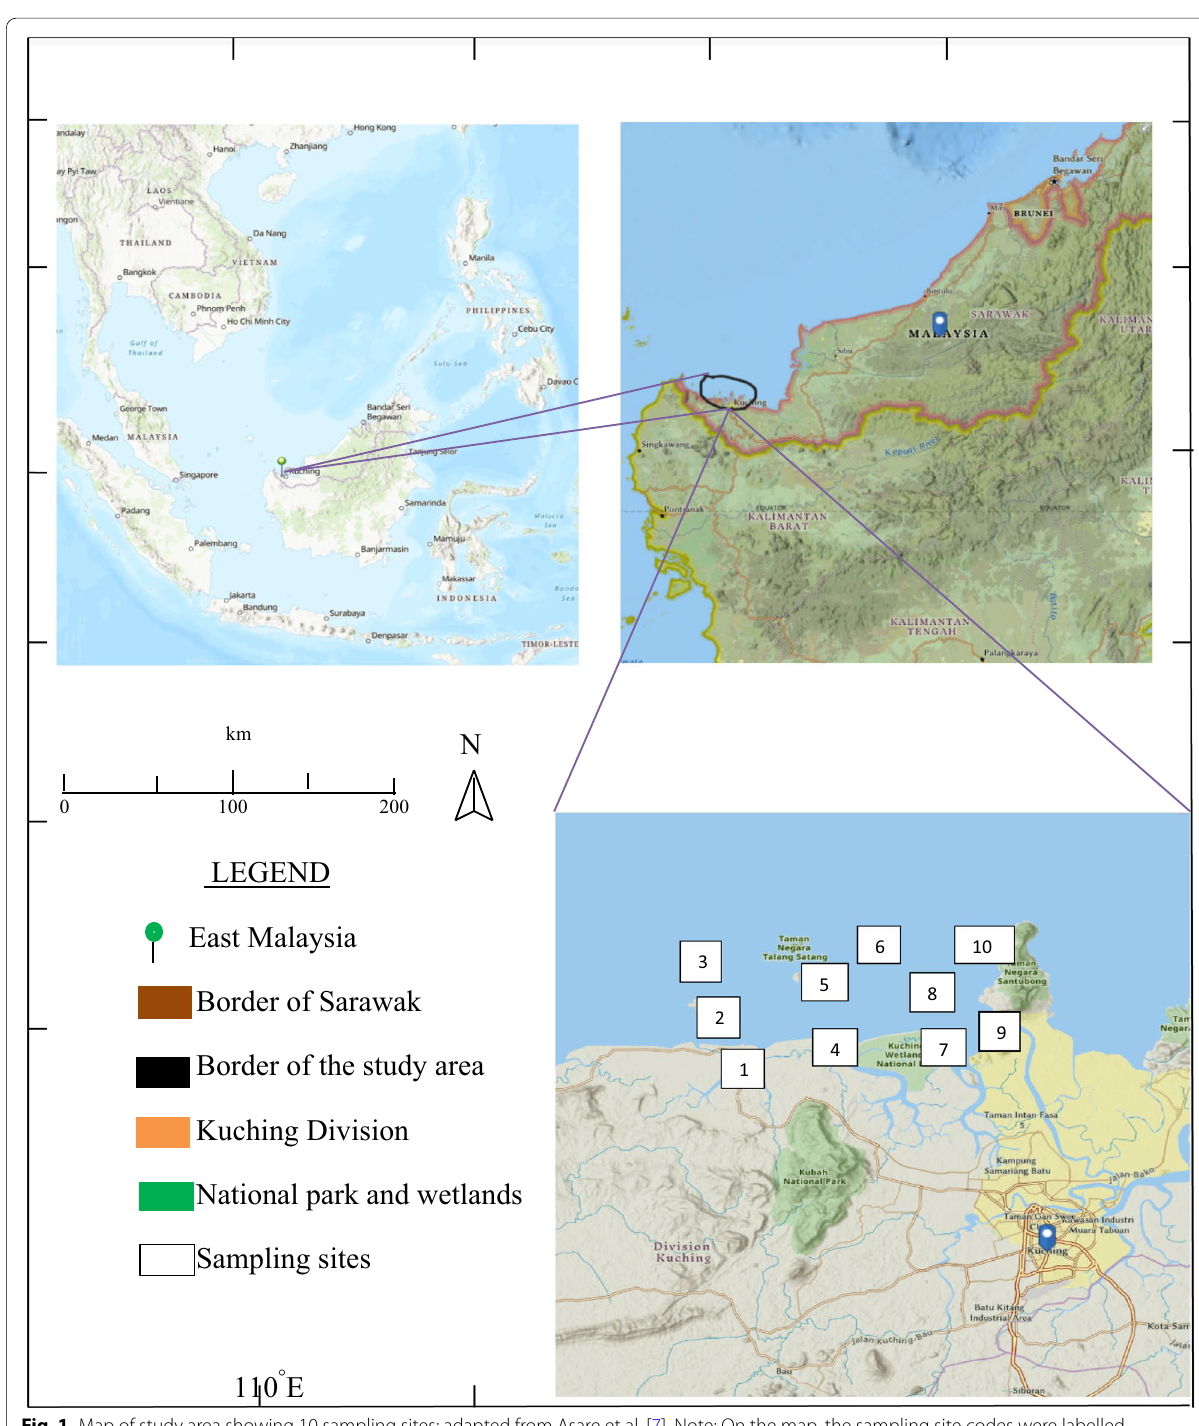
Fig. 1 Map of study area showing 10 sampling sites; adapted from Asare et al. [7]. Note: On the map, the sampling site codes were labelled numerically for easy identification of sampling position but the actual naming of each sampling site is attached with CZ for example sample site